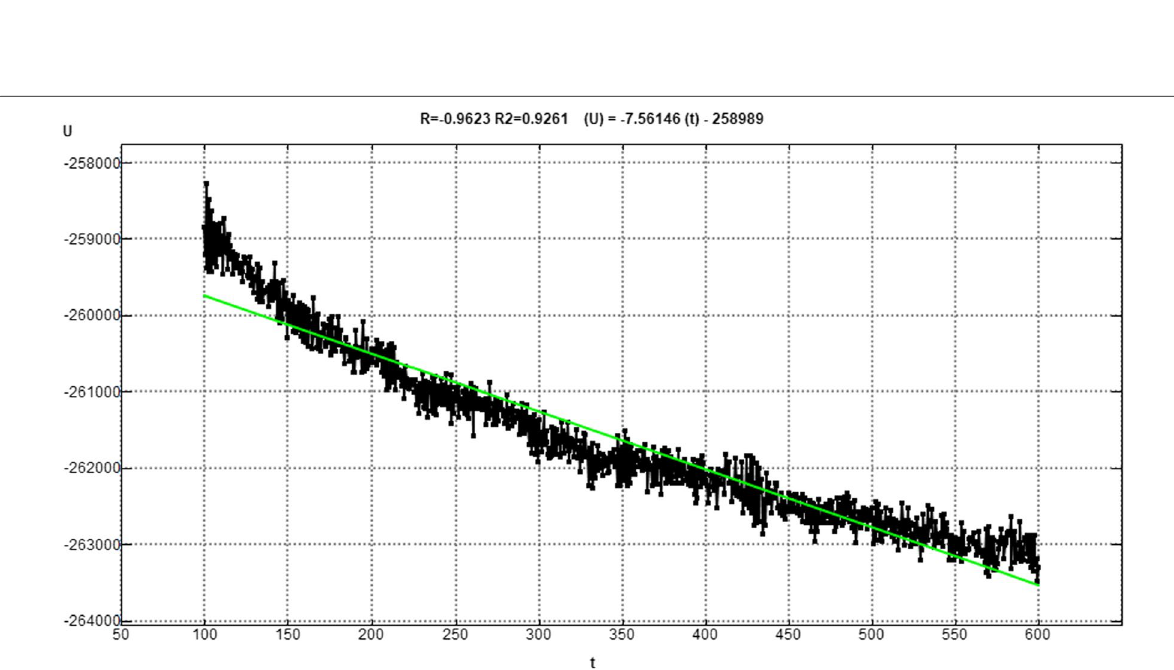
Fig. 16 Plot of Internal Energy ( U ) versus time ( t ) for molecular dynamics study of inhibitor with Index number